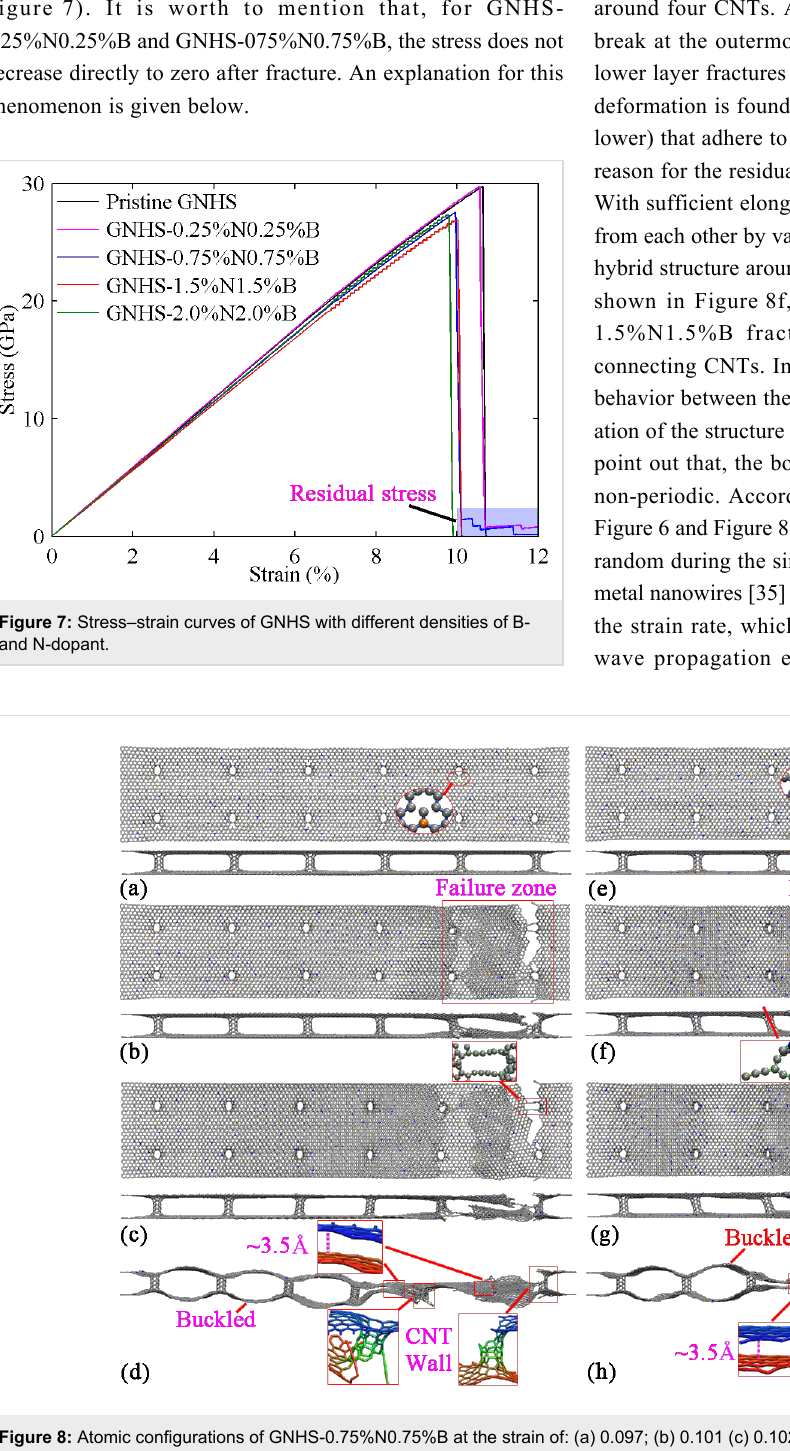
Figure 8: Atomic configurations of GNHS-0.75%N0.75%B at the strain of: (a) 0.097; (b) 0.101 (c) 0.102; (d) 0.115. Atomic configurations of GNHS- 1.5%N1.5%B at the strain of: (e) 0.097; (f) 0.101; (g) 0.102; (h) 0.103.